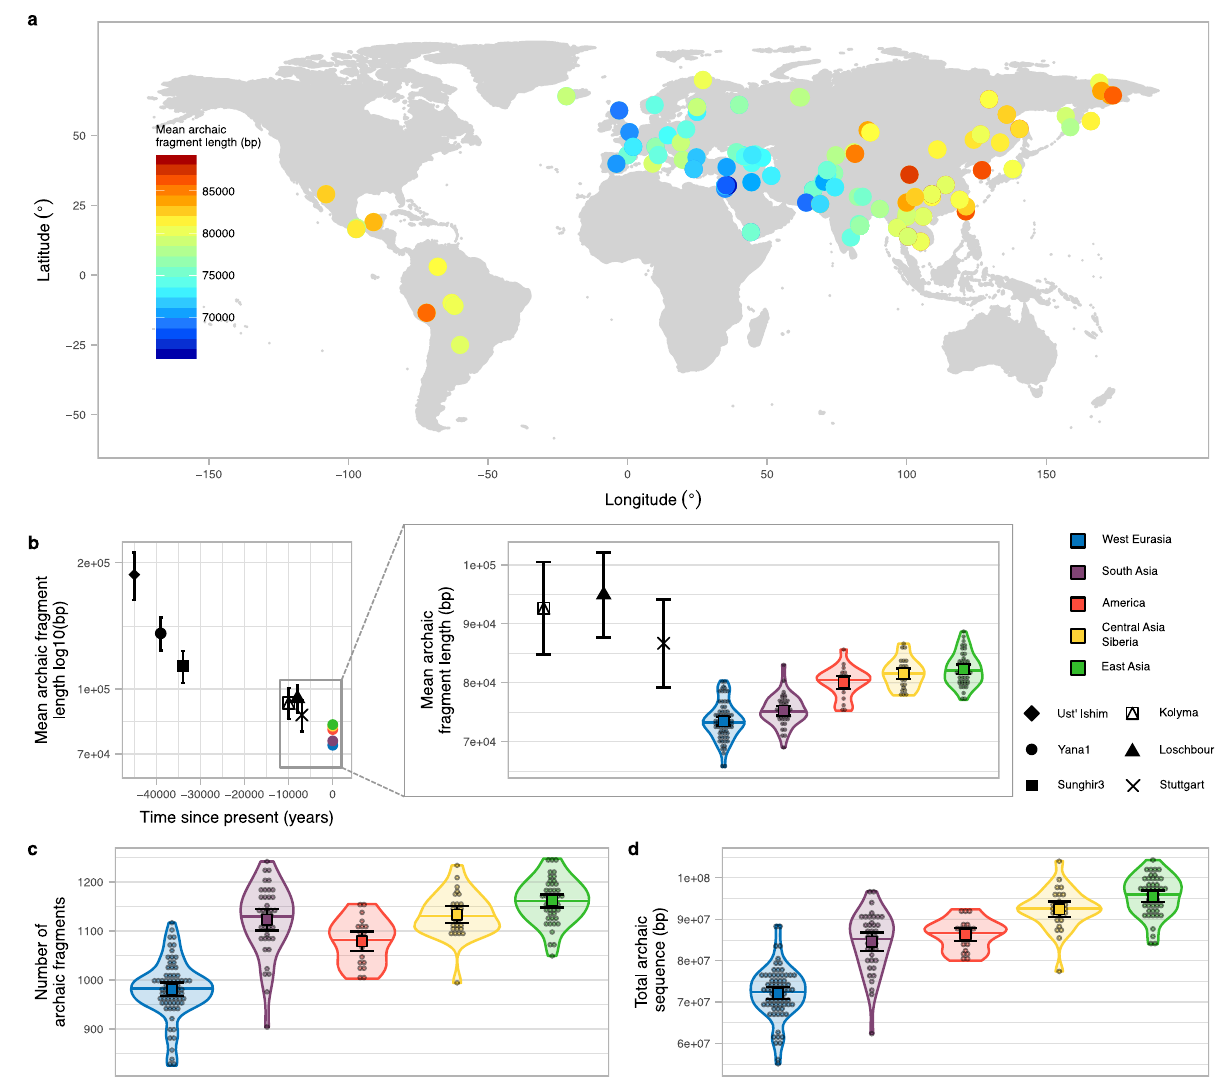
Fig. 1 Archaic fragment statistics distributions around the world and in ancient samples. a World map (Methods) showing as circles the samples from SGDP used in this study coloured according to the mean archaic fragment length. b Mean archaic fragment length of extant geographical regions and ancient samples. Ust ’ -Ishim, Yana1, Sunghir3, Kolyma, Loschbour and Stuttgart mean archaic fragment lengths are shown as black points with speci fi c shapes with their corresponding 95%CI as error bars. The sample sizes of fragments for which summary statistics are derived, together with other statistics, are indicated in Supplementary Table 3. The average of the mean archaic fragment length among all individuals in each of the fi ve main regions are shown as points (colour-coded). The zoom-in shows the mean archaic fragment length distribution per region (colour coded) as a violin plot. Individual values are shown as dots. The median is shown as a horizontal line in each violin plot. The mean and its 95%CI of each distribution are shown as a coloured square with their corresponding error bars. The sample sizes of individuals for each region for which summary statistics are derived, together with other statistics, are indicated in Supplementary Table 2. Kolyma, Loschbour and Stuttgart mean fragment lengths are also shown for comparison. c , d The number of archaic fragments and the archaic sequence distributions, respectively, per region (colour coded) as violin plot. Individual values are shown as dots. The median is shown as a horizontal line in each violin plot. The mean and its 95%CI of each distribution are shown as a coloured square with their corresponding error bars. The sample sizes of individuals for each region for which summary statistics are derived, together with other statistics, are indicated in Supplementary Table